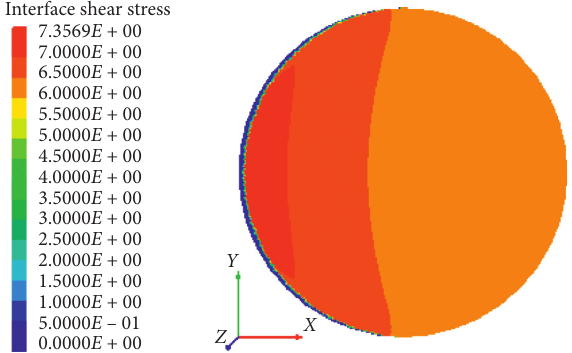
Figure 10: Shear stress distribution on the shear failure plane.